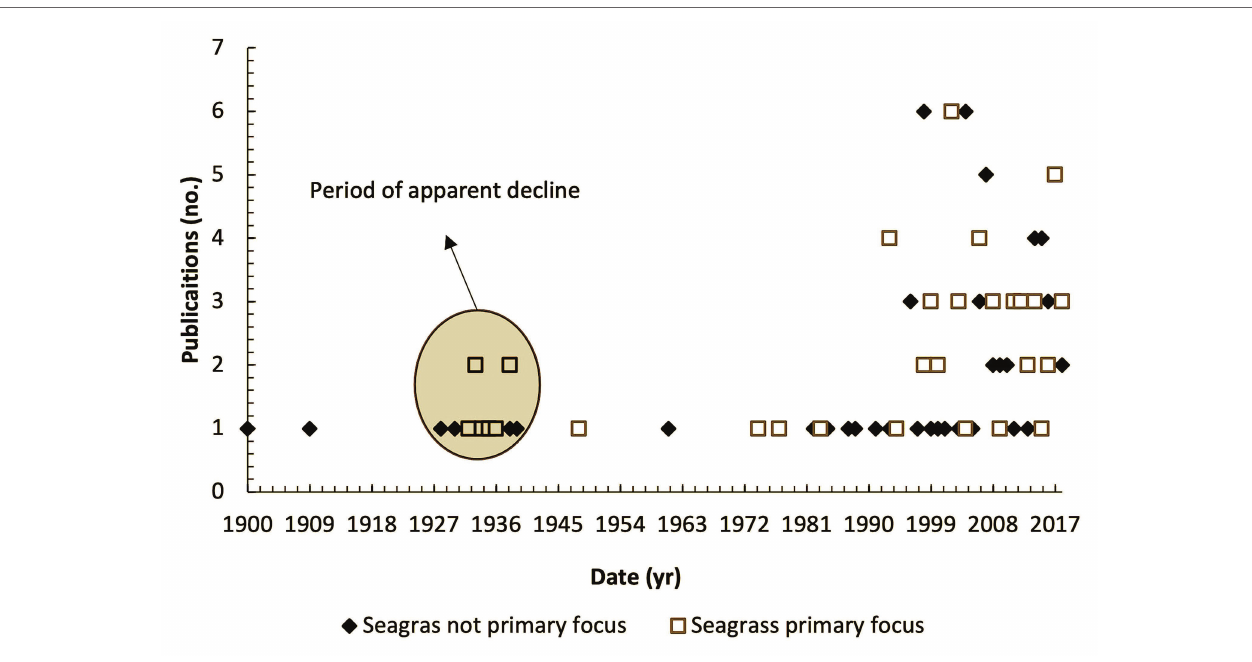
FIGURE 3 | Number of publications (grey and peer reviewed) relating to United Kingdom seagrass habitats by date where seagrass is primary focus (orange square) and seagrass is significant secondary focus (blue diamond).